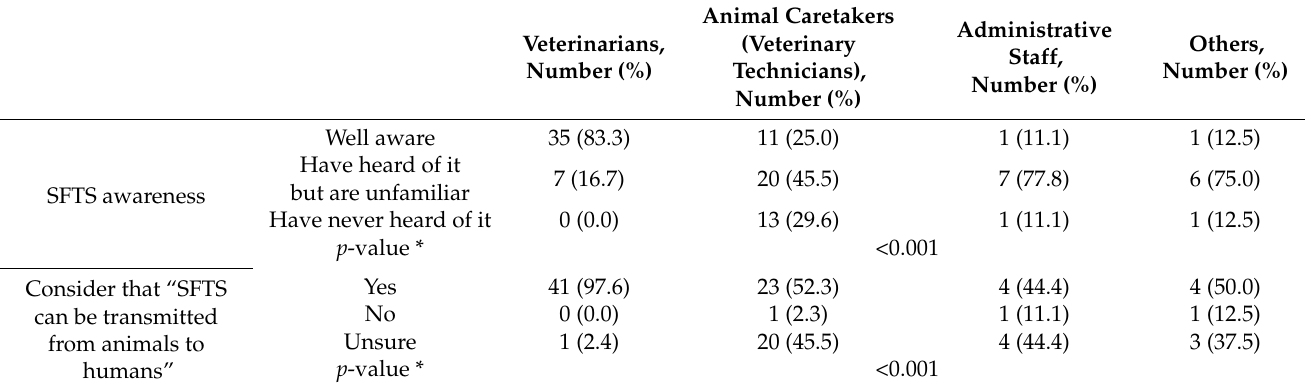
Table 4. SFTS awareness according to